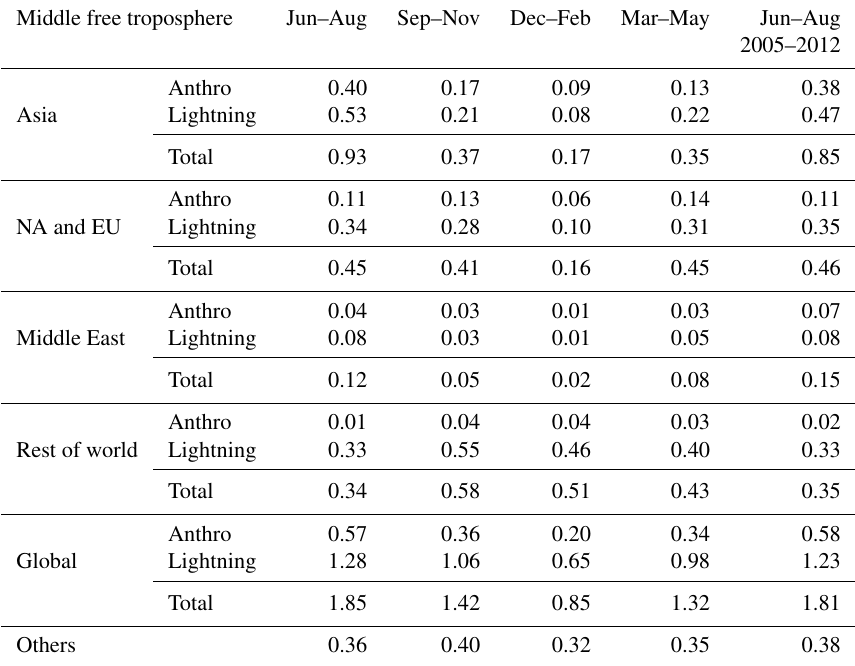
Table 1. Response of middle free tropospheric (450–350hPa) O 3 over Middle Eastern Asia (30–60 ◦ E, 20–40 ◦ N) to NO x emission pertur- bation in the period of March 2005–February 2006. The value can be explained as the mean change (unit of ppbv) of regional mean O 3 due to 10% increase of NO x emission in a particular region (Asia, North America (NA) and Europe (EU), Middle Eastern Asia, and the rest of the world) assuming unchanged chemical environment. The last column shows the multiyear mean value for June–August